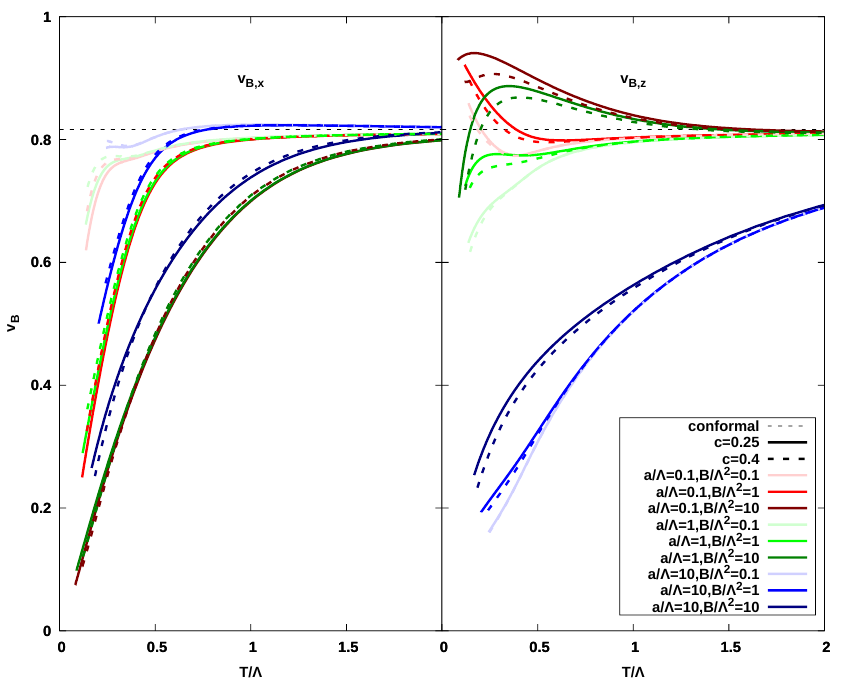
Figure 14 . Components of the butterfly velocity as a function of temperature (in units of Λ ∼ 1 GeV) for the parallel configuration. In this case both the magnetic field B and the anisotropic deformation are introduced along the z -direction. The solid lines depict results for c = 0 . 25 , which we have kept for comparison, while dashed lines show the corresponding results for c = 0 . 4 . The component v z is also enhanced in the IR and exceeds the bound found in [27], although it is slightly B smaller than in the perpendicular case. In this case, the increase in c also makes v z smaller, while B there is no clear pattern for the other component, v x B